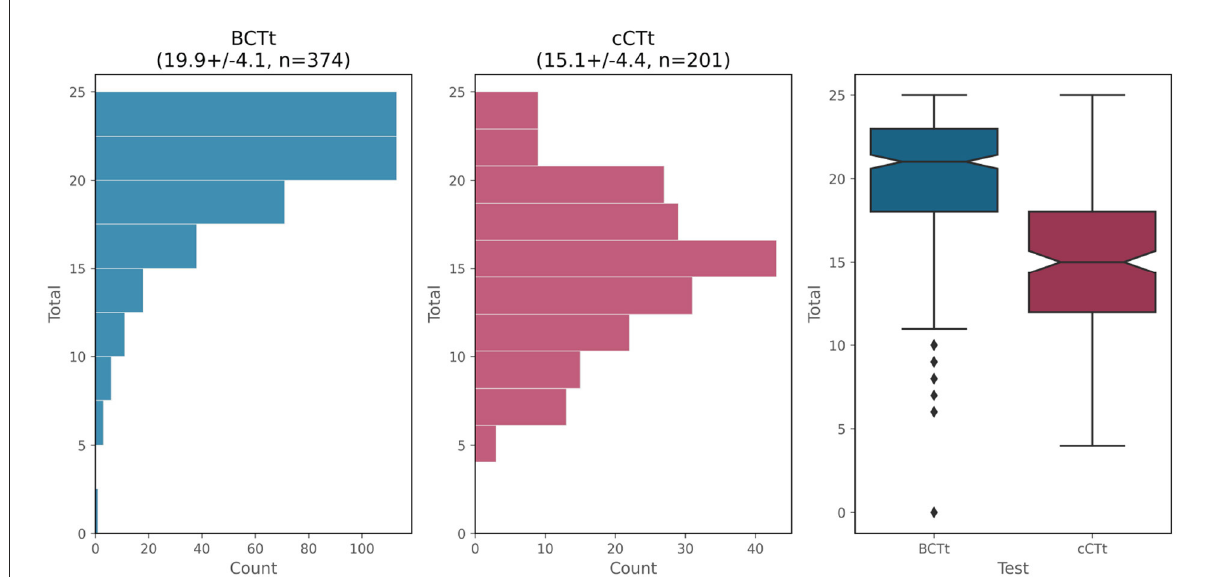
FIGURE3 Score distribution for the BCTt and cCTt. The histogram and boxplots show the ceiling effect of the BCTt while the cCTt exhibits a normal distribution centered around 15/25 (i.e.,